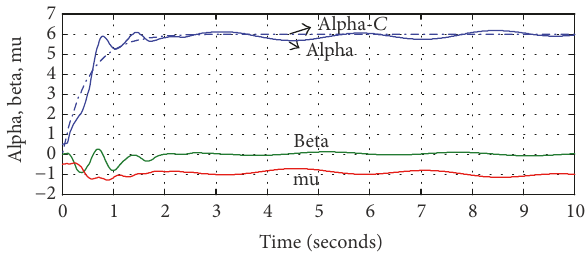
Figure 11: Compensated tracking results.